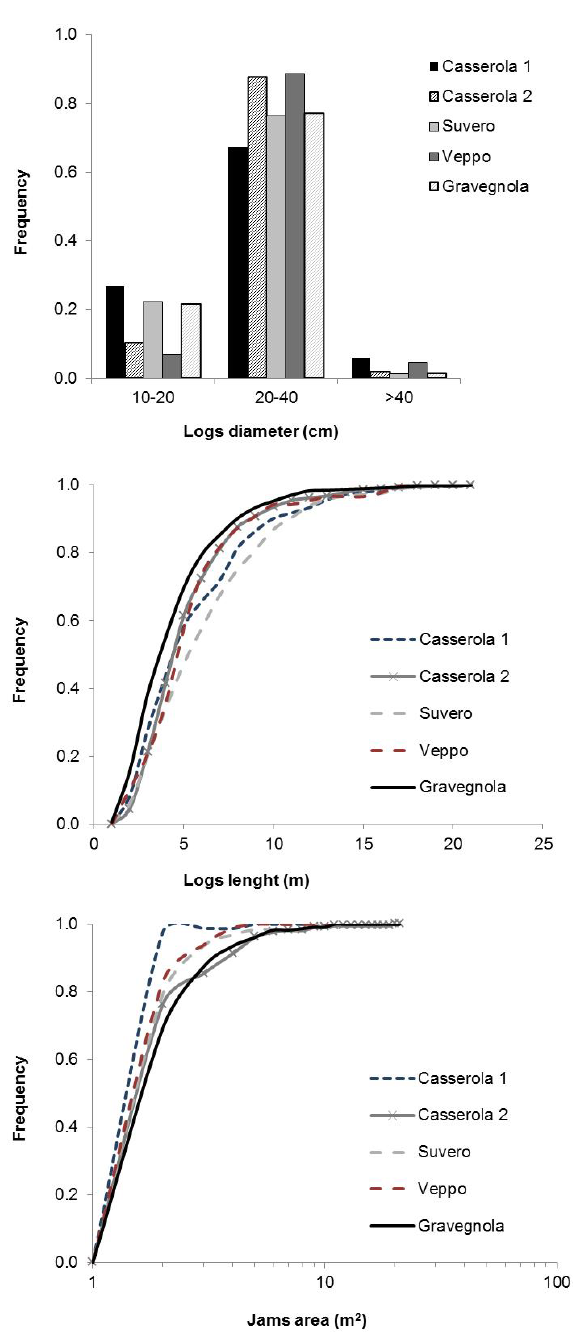
Figure 10. Frequency of log dimensions: the three categories of Log diameter (above) the length (middle) and the jam area (below) in the different